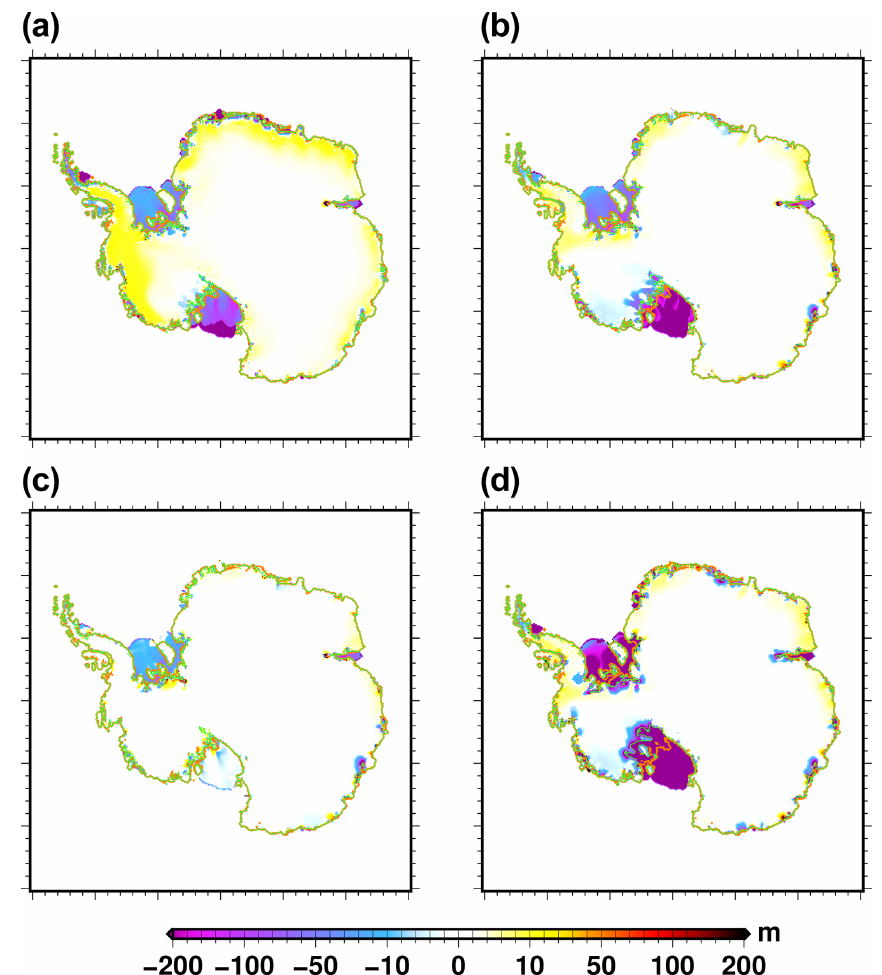
Figure 7. Simulated ice thickness change (2100–2015) for (a) CESM2 (SSP585), (b) NorESM1-M (RCP8.5), (c) NorESM1-M (RCP2.6) and (d) NorESM1-M (RCP8.5) PIGL . The orange line shows the present-day grounded line, and the light-green line represents its simulated position in 2100. The medium oceanic sensitivity has been used here, except for the PIGL experiment (d) , for which we use the high oceanic sensitivity. The ice thickness change shown here is corrected for the ice thickness change (2100–2015) in the control experiment ctrl_proj